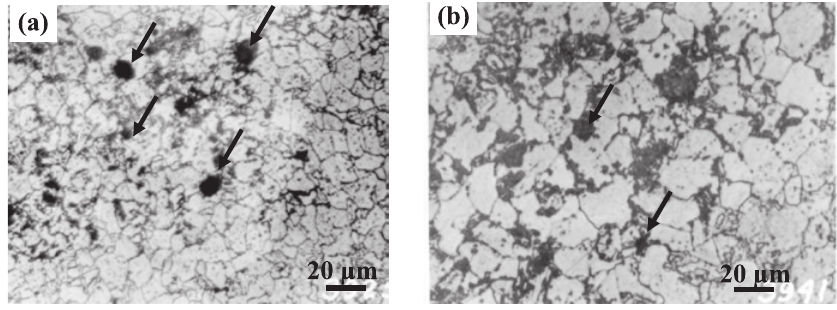
Fig. 7: Microstructures (a) in the vicinity of puncture showing micro-voids and (b) opposite to puncture